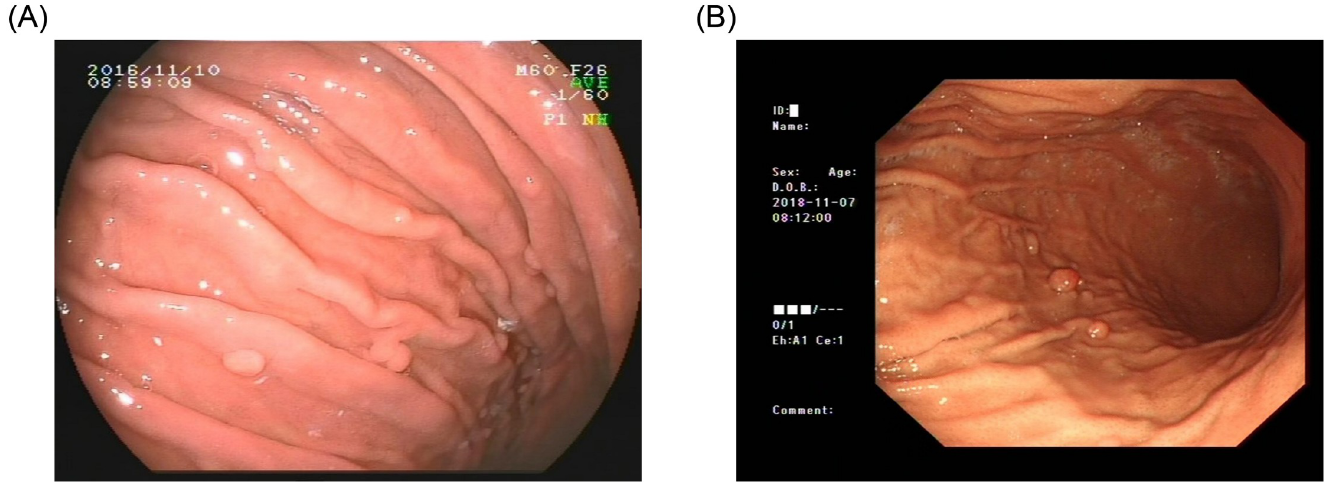
Fig 4. Two types of gastrointestinal polyps images using in this work. (A) Fujinon Iamge; (B) Olympus Image.